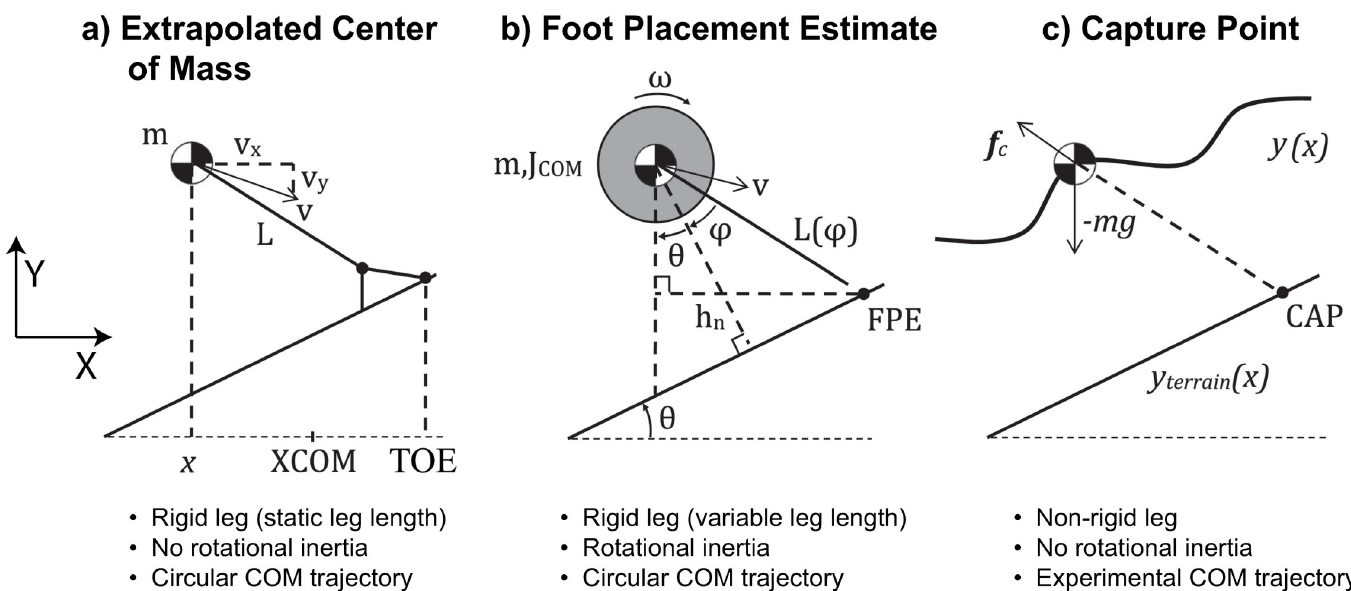
Fig 1. Inverted pendulum model diagrams. Diagrams illustrating the models used for calculating stability metrics: the extrapolated center of mass (XCOM, a), foot placement estimate (FPE, b), and capture point (CAP, c). The ramp angle and the angle of the leg relative to the vertical have been exaggerated for clarity. A summary of key model characteristics is given below each